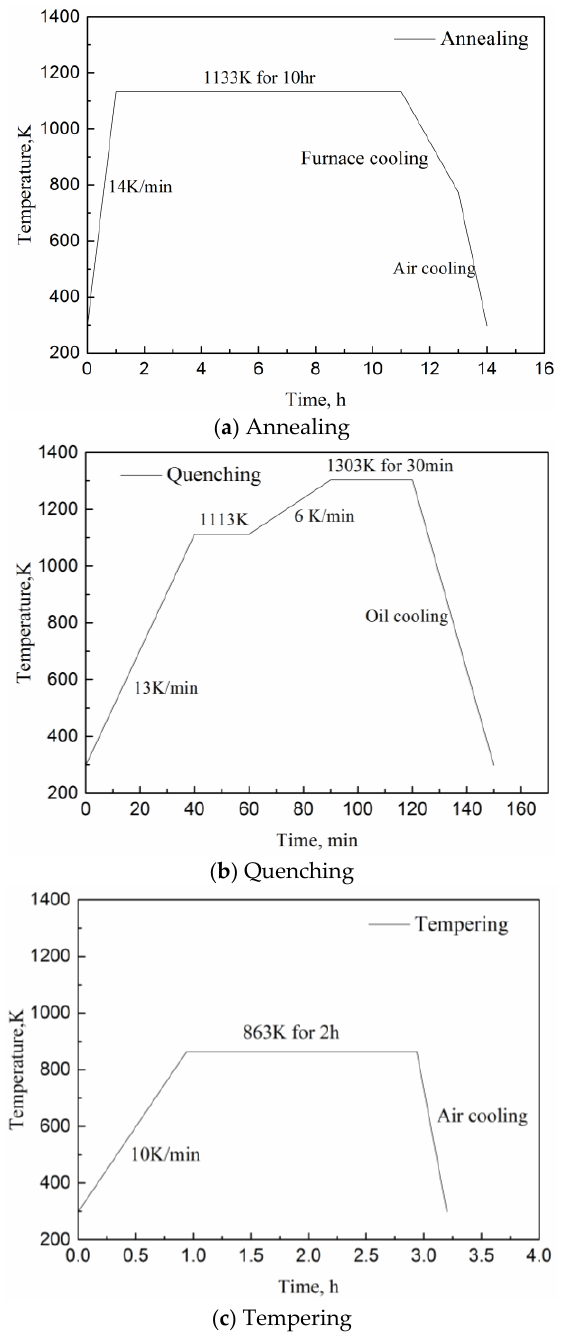
Figure 1. Heat treatment for the H13 ingot after forging. ( a ) Annealing; ( b ) Quenchin; ( c ) Temperin.